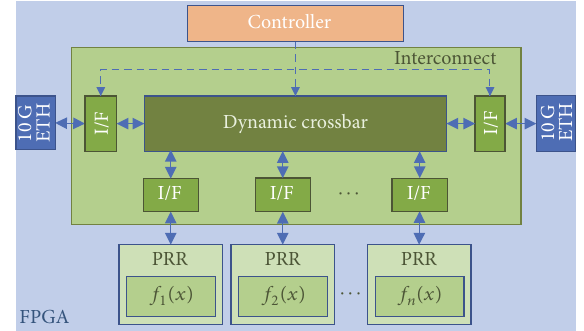
Figure 3: The overview of the proposed FPGA virtualization architecture for NFV